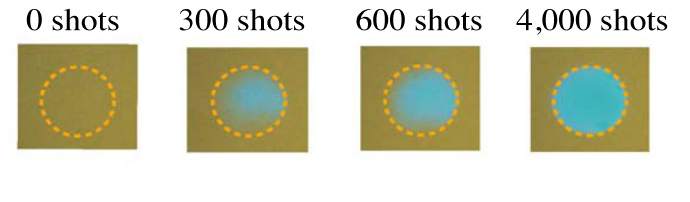
Figure 6. Photodegradation of β -carotene in PMMA film with different numbers of laser shots. The excitation photon density is 3.0 × 10 15 photons/cm 2